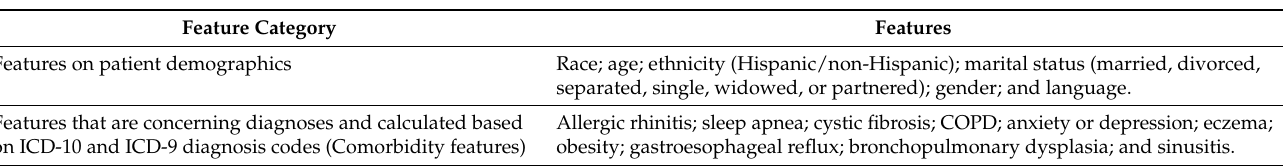
Table A3. The list of candidate features considered in model_3.